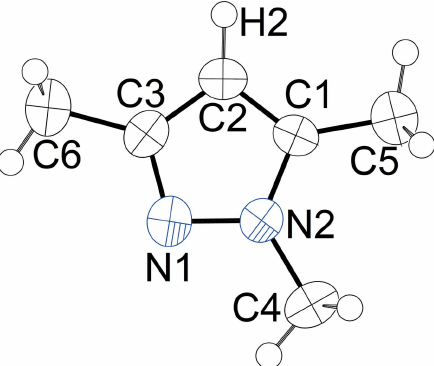
Figure 1 Displacement ellipsoid plot (Spek, 2020) of a molecule in 1 ; ellipsoids are drawn at 70% probability, H atoms are shown as spheres of arbitrary radii. Selected distances (A˚ ) and angles ( (cid:4) ): N1—N2 1.358 (4), N2—C1 1.351 (4), C1—C2 1.360 (5), C2—C3 1.392 (4), N2—C4 1.448 (4), C3— N1—N2 104.2 (3), C1—C2—C3 106.6 (3).